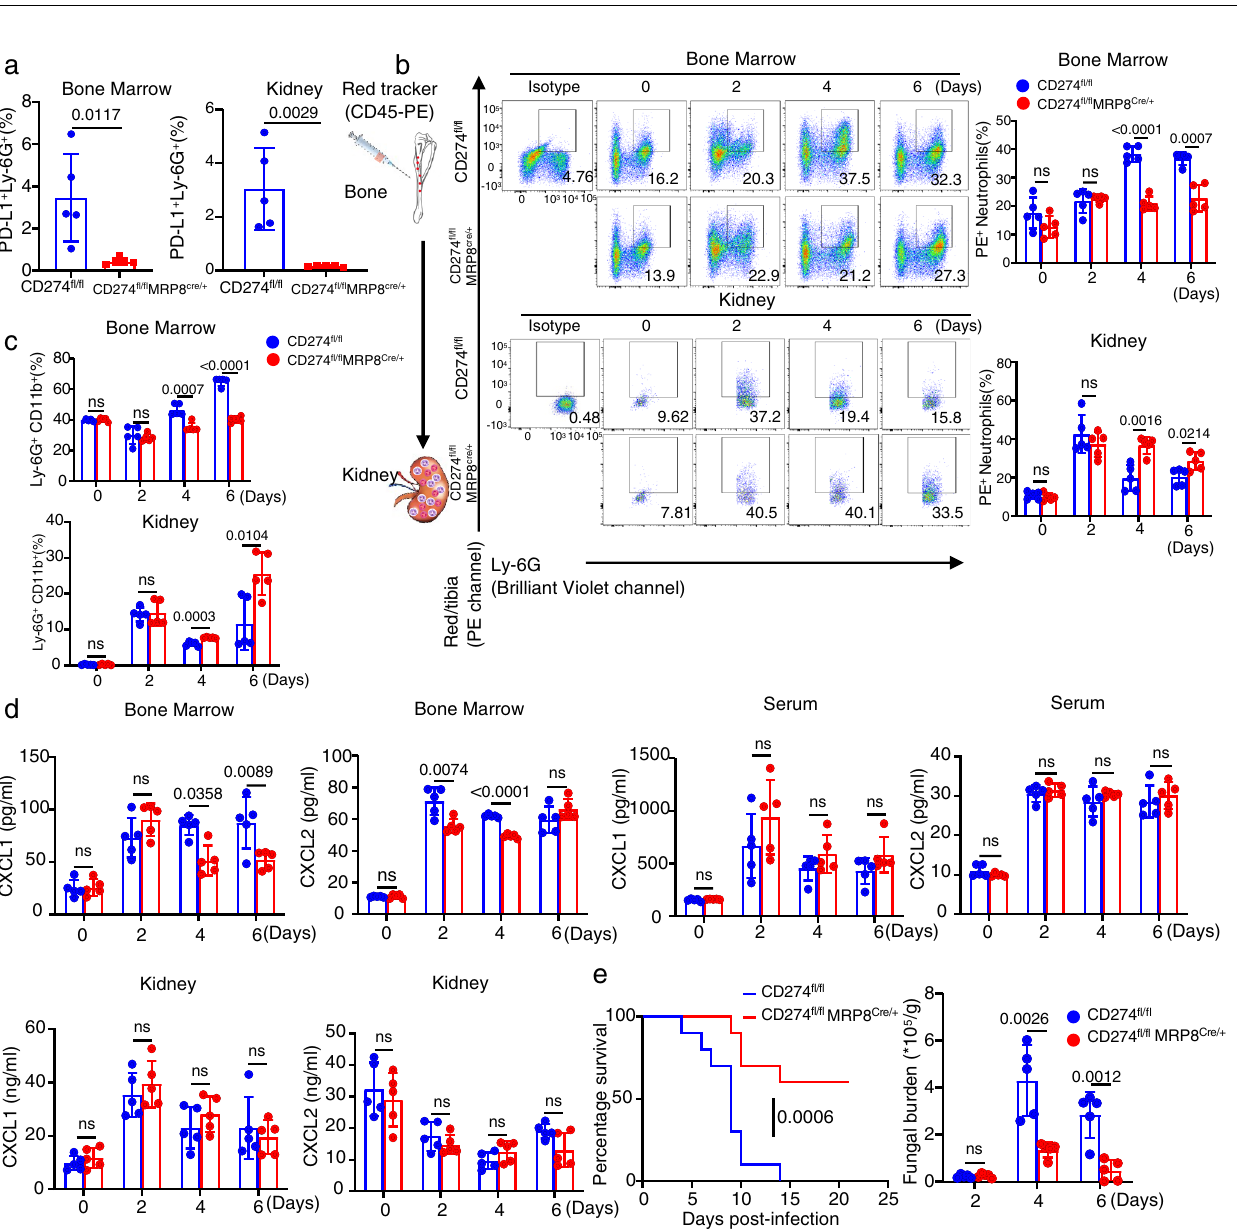
Fig. 4 | De fi ciency of PD-L1 signi fi cantly increases survival of C. albicans - infected mice through promoting neutrophil migration from bone marrow into kidney. a Neutrophil tracking assay in the bone marrow and kidney of wild- typeand Cd274 − / − mice,whichwere intravenouslyinfectionwith C.albicans SC5314 (2×10 5 CFU/mouse) for indicated days. PE-labeled anti-CD45 (10 μ l) were micro- injected into one tibia for 12h before scari fi cation at each indicated time. b – e The percentage of neutrophils in bone marrow and kidney ( b ), ELISA quanti fi cation of CXCL1 and CXCL2 in bone marrow ( c ), survival and kidney fungal burden ( d ), and PASstaining( e )ofkidneyofwild-typeand Cd274 − / − mice,whichwereintravenously infection with C. albicans SC5314 (2×10 5 CFU/mouse) for indicated days. Scar